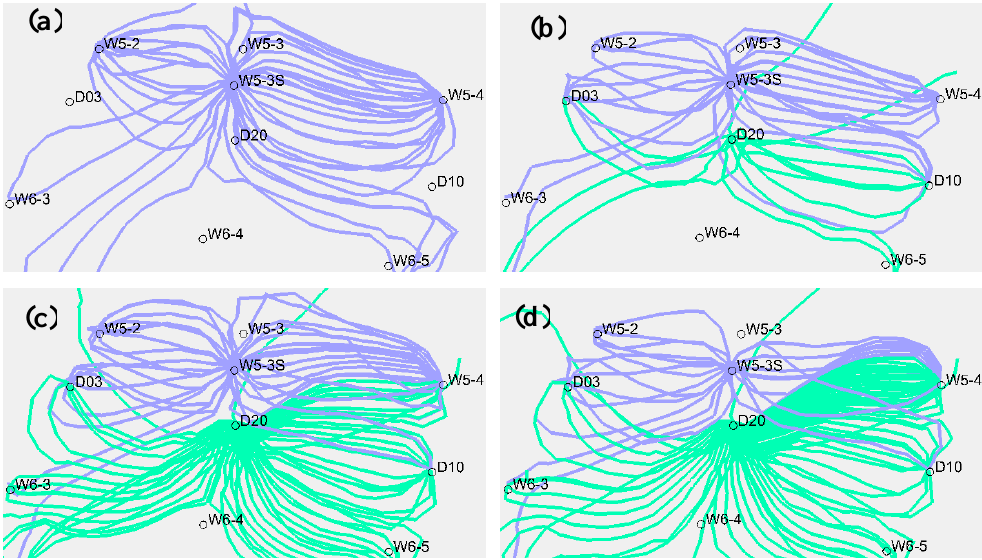
Figure 10. The streamline field of ( a ) un-injected polymer, ( b ) injected polymer, 0.045 PV, ( c ) injected polymer, 0.09 PV, and ( d ) injected polymer, 0.135 PV of the W5-3S well group in the water/polymer flooding stage.